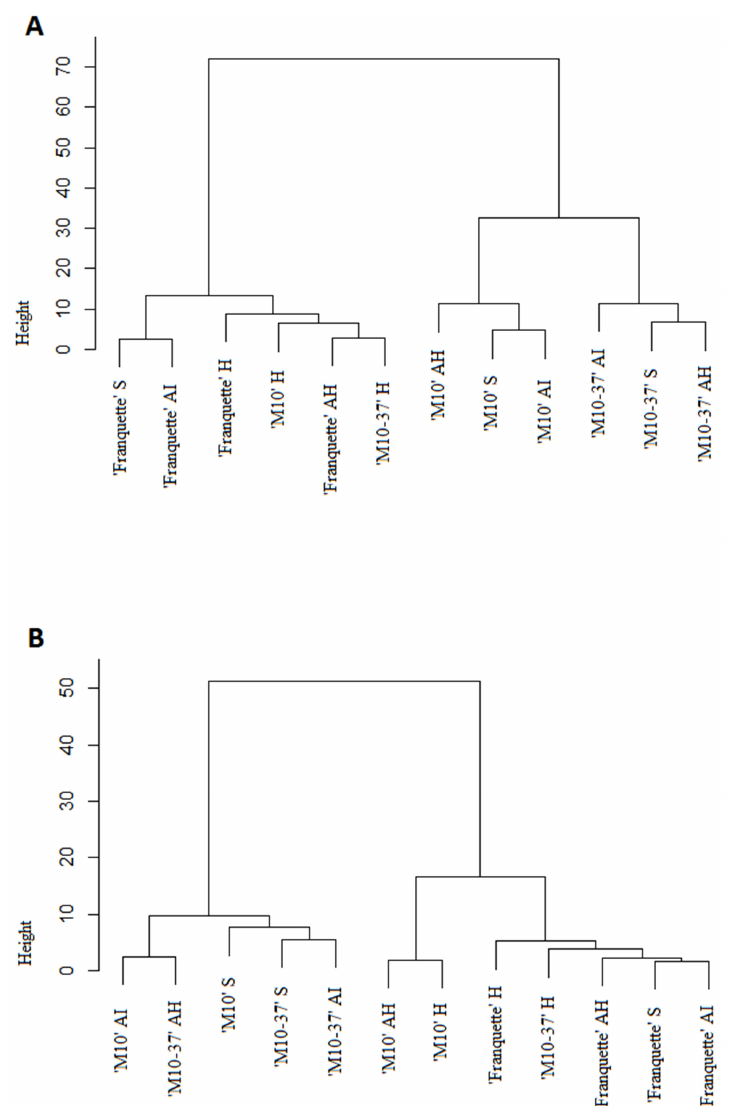
Figure 3. Dendrogram showing the grouping of naphthoquinones ( A ) and flavanols ( B ) between the severities of walnut anthracnose-affected tissues of three cultivars, using Ward’s method (squared Euclidean distance) based on total phenolic compounds. Data are standardized ( μ = 0, σ = 1). S: inner spot of infected tissue; AI: outer margin of infected tissue; AH: healthy tissue surrounding the infection; H: healthy tissue.